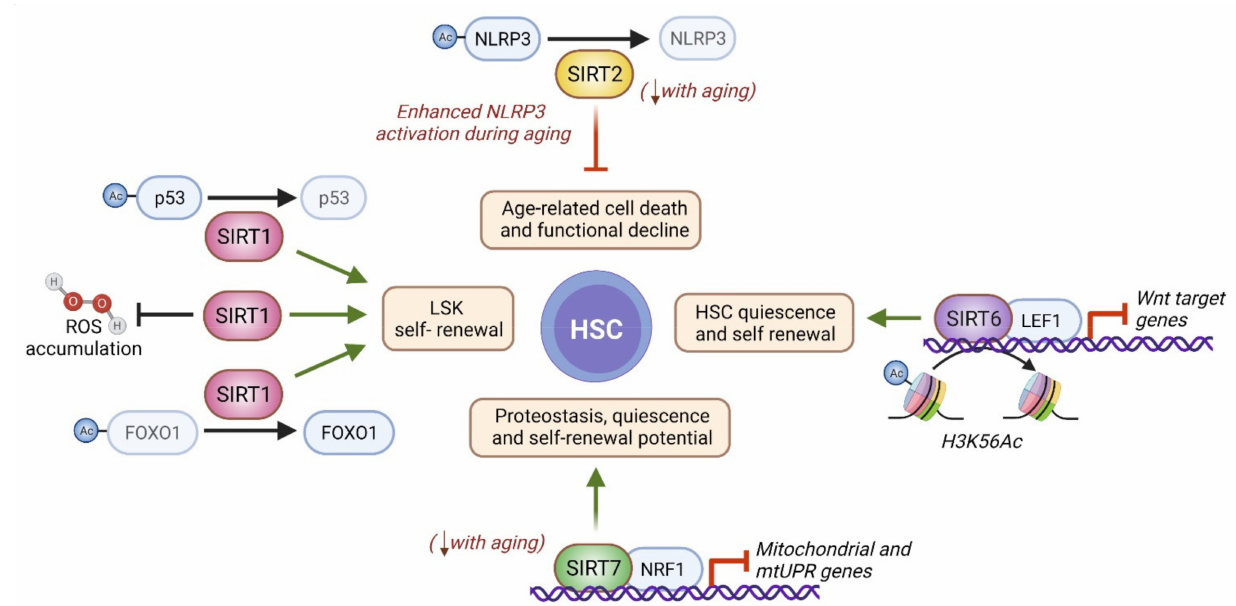
Figure 3. Molecular basis of nuclear sirtuin functions during HSC aging. In vitro cultured LSK cells from Sirt1 -/- mice show lower self-renewal capacity as a consequence of a mechanism involving FOXO suppression, p53 activation, and ROS accumulation [35]. In HSCs from young mice, SIRT2 inactivates the NLRP3 inflammasome by deacetylation to mitigate cell death. During aging, SIRT2 becomes downregulated in HSC, which provokes enhanced NLRP3 activation and age-related HSC functional decline [36]. SIRT6 is recruited by the Wnt transcription factor LEF to the promoters of Wnt target genes, where it deacetylates H3K56Ac to suppress their expression. In this way, SIRT6 contributes to the maintenance of HSC quiescence and self-renewal potential [37]. Finally, SIRT7 is recruited to mitochondrial- and mtUPR-related genes in a NRF1-dependent manner in HSCs to repress their expression and ensure mitochondrial proteostasis and HSC quiescence and self-renewal potential [38]. Faded lines indicate age-related loss of function, and comments in red indicate age-related changes. Figure created with